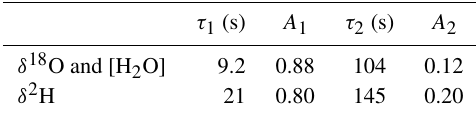
Figure 2. The normalized response curves of the spectrometer for switching between the GS-48 and BEW-2 isotope standards, both prepared as a mixture of ∼ 600ppmv water vapor in dry air. The experimental data are fit with a double exponential, yielding 9.2 and 20.7s for the fast decay times for δ 18 O (red curve) and δ 2 H (green curve), respectively. It is noted that the update frequency of the water isotope spectrometer is 2Hz (Landsberg et al., 2014). Table 1. Parameters of the double exponential fit to the measured in- strument response for δ 18 O and δ 2 H. The water vapor concentration is observed to closely follow the δ 18 O behavior and was modeled with the δ 18 O